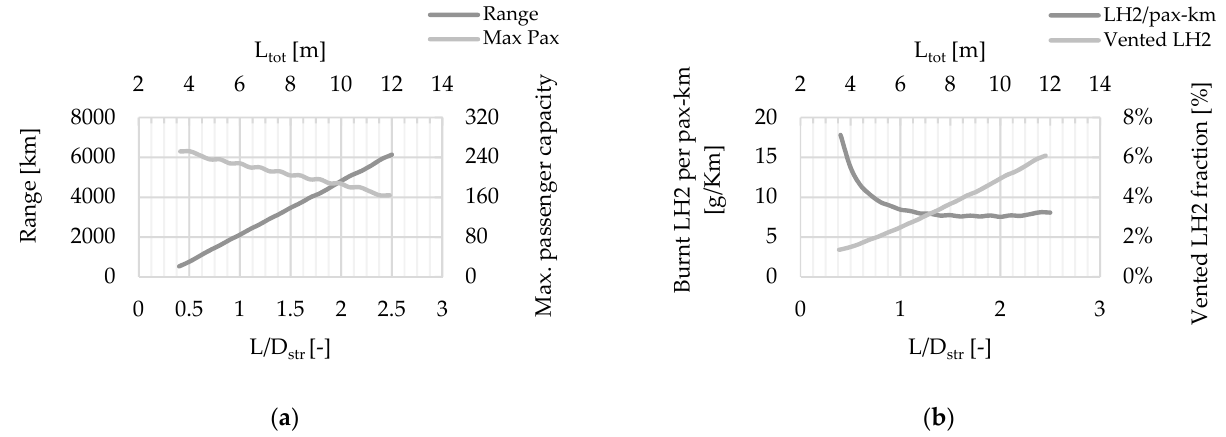
Figure 20. Sensitivity to L / D str : ( a ) range and seat capacity, ( b ) burnt LH 2 per pax-km and vented mass fraction.